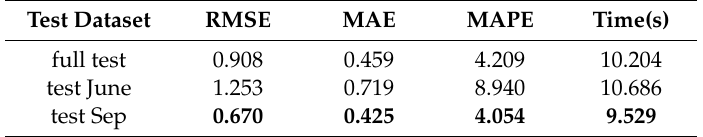
Table 7. Y(1) Prediction of the proposed models built with full training dataset.